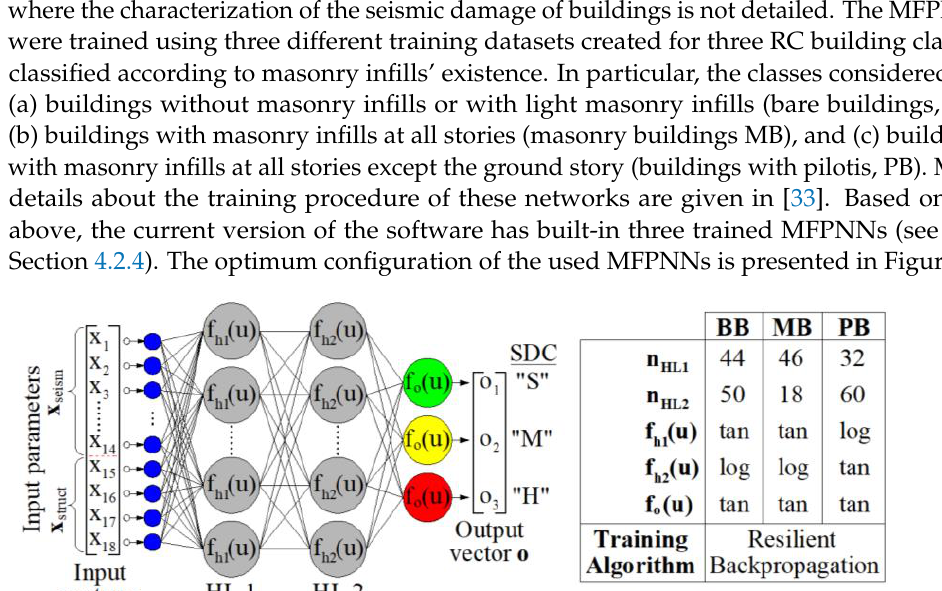
Figure 2. Configuration parameters of the optimum MFPNNs used in the current version of the software.